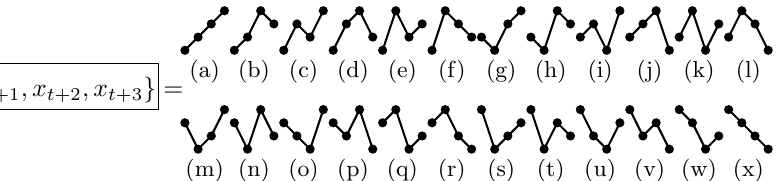
Figure 7. Schematic illustration of 24 ordinal patterns that can be defined from D = 4 consecutive data values in a time